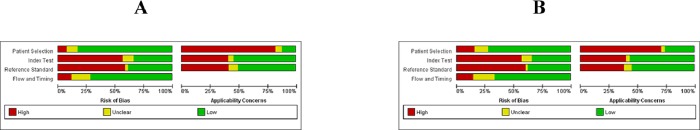
The overall methodological quality of all included studies for tuberculosis detection versus (A) culture reference standard, and (B) CRS.